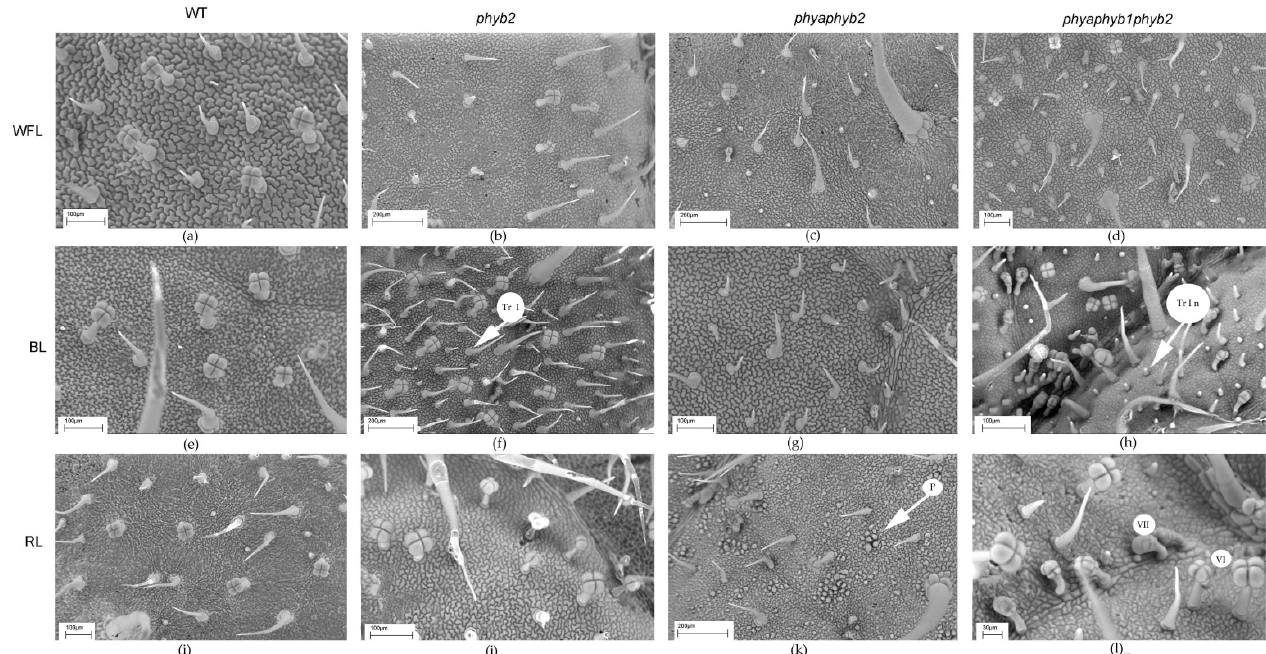
Figure 4. SEM photograph showing the adaxial surface of tomato leaf mutants for the main phy- tochrome genes: WT ( a , e , i ); phyb2 ( b , f , j ); phybaphyb2 ( c , g , k ) and phyaphyb1phyb2 ( d , h , l ) under the action of WFL ( a – d ), BL ( e – h ) and RL ( i – l ). Tr I—trichomes of type I; Tr I n—underdeveloped tri- chomes of type I; VI—trichomes of type VI; VII—trichomes of type VII; and P—papillose for- mations on the outer surface of the main cells of the epidermis.